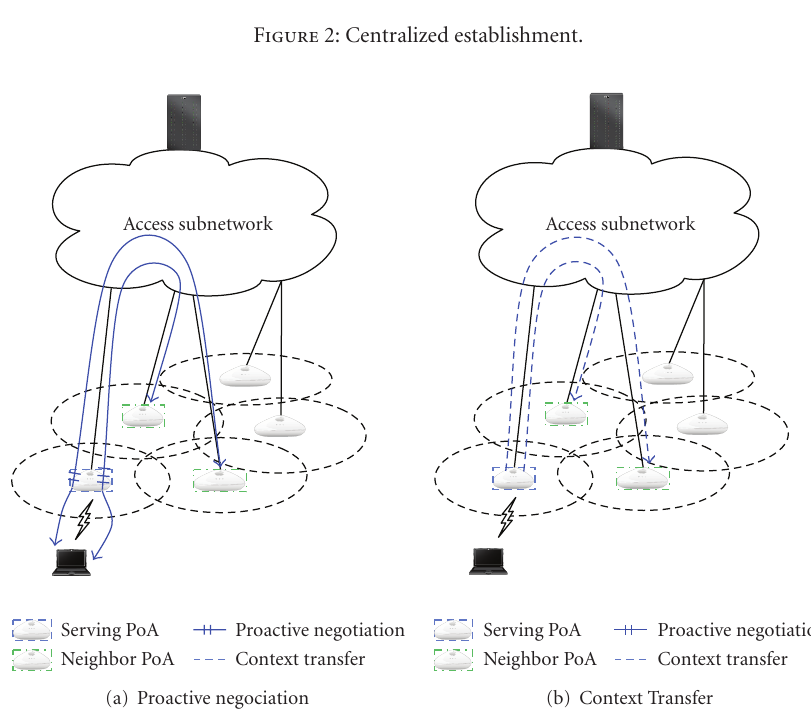
Figure 3: Distributed